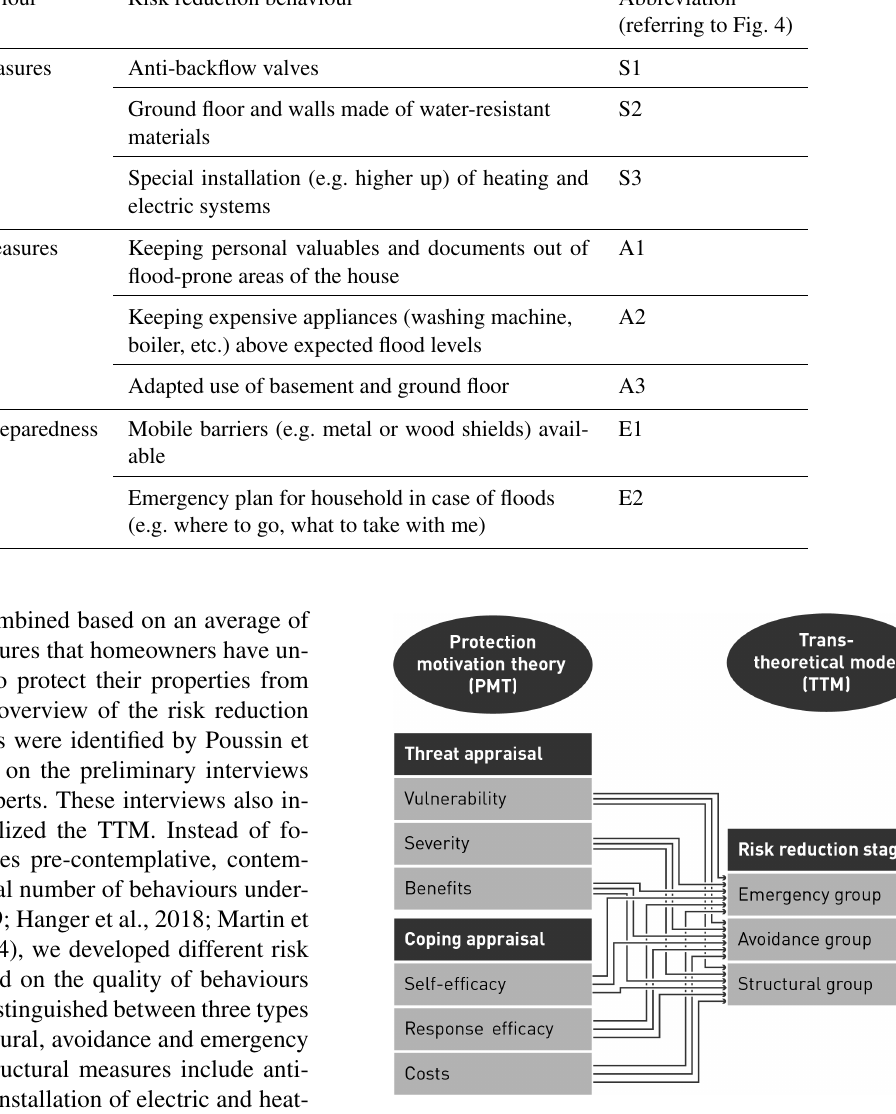
Figure 3. Dynamic protection motivation framework that builds on the protection motivation theory (PMT) and the transtheoretical model (TTM). The arrows highlight that, in each group, people are influenced by different PMT variables to engage in risk reduction